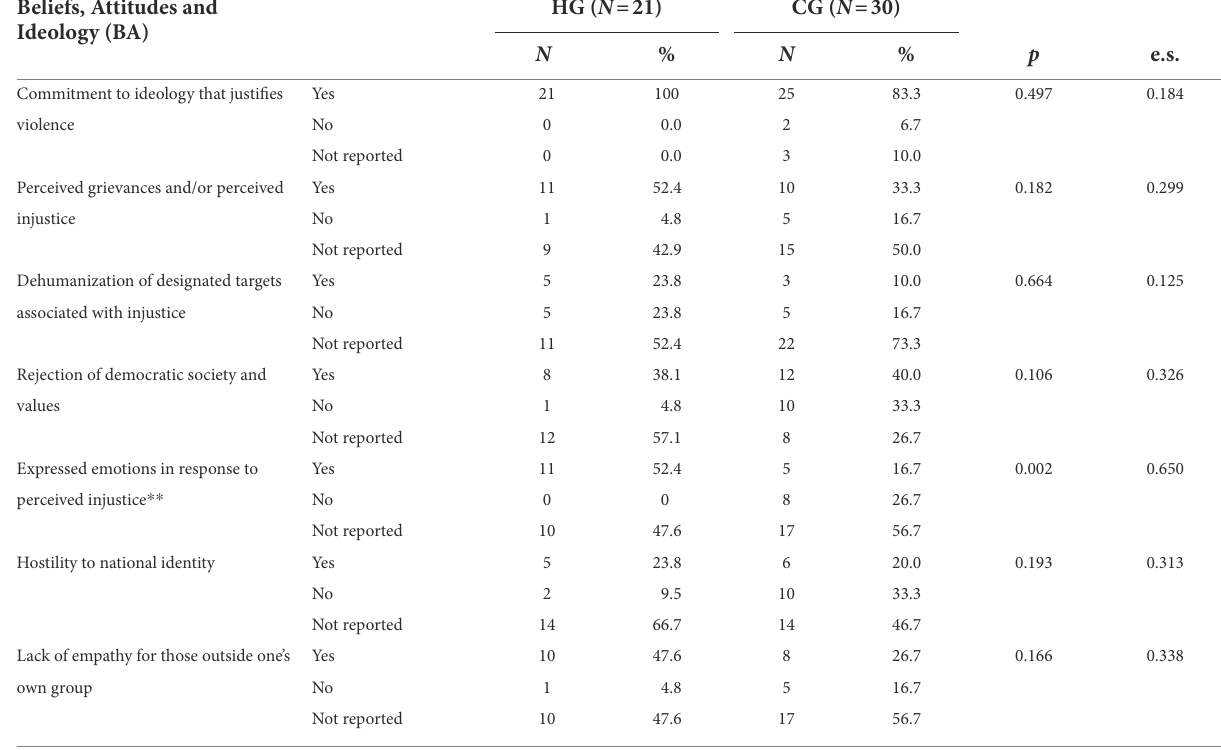
TABLE 3 Beliefs, attitudes and ideology in male Jihadist homicide offenders (HG) and male Jihadist non-homicide offenders (CG). Beliefs, Attitudes and Ideology